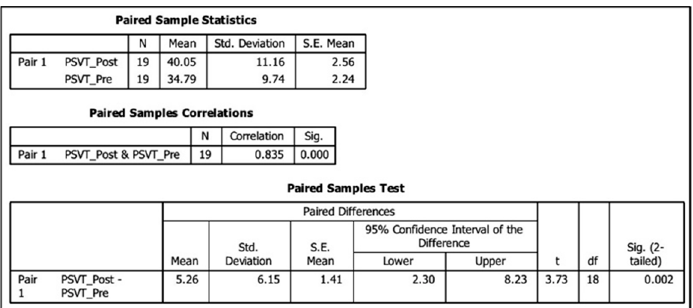
Figure 16. Paired t-test for the non-Computer Graphics group.